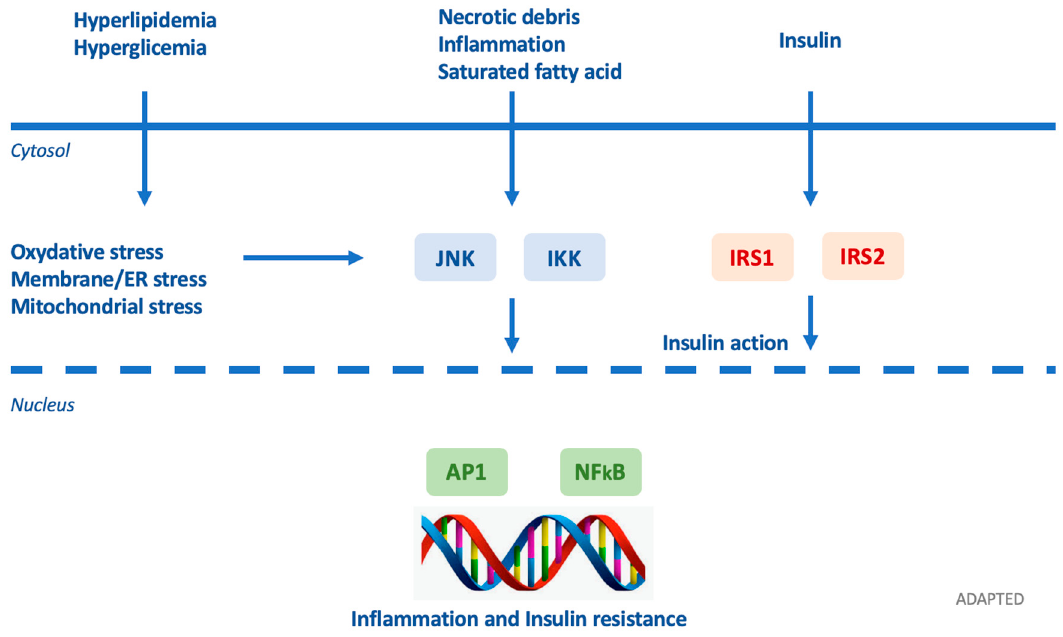
Figure 6. Adapted by Petrakie et al. Inflammatory signaling pathways link nutrient excess to insulin resistance. Cytoplasmic / nuclear responses via tyrosine phosphorylation of insulin receptor substrate (IRS)-1 and IRS-2 are activated by the presence of insulin at the cell surface. Nevertheless, insulin signaling is potentially inhibited by serine phosphorylation of these proteins by Jun N-terminal kinases (JNK) and inhibitor of nuclear factor κ B (NF- κ B) kinases (IKK). Various intra / extracellular sequelae of chronic nutrient excess activate these signaling pathways, linking overfeeding to insulin resistance. JNK and IKK activation triggers inflammatory cytokine production, activating JNK / IKK in an autocrine / paracrine manner, further reinforcing insulin resistance. ER: endoplasmic reticulum; AP-1: activator protein-1. Arrows identify the subsequentiality of events.